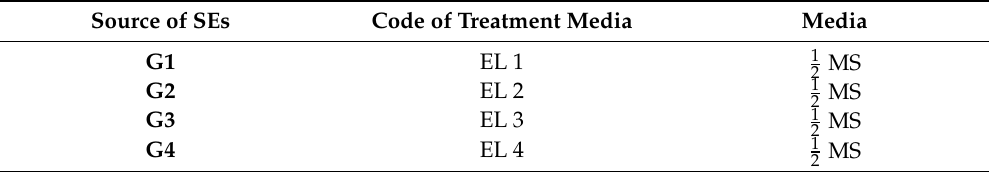
Table 11. The treatments composition during elongation phase.